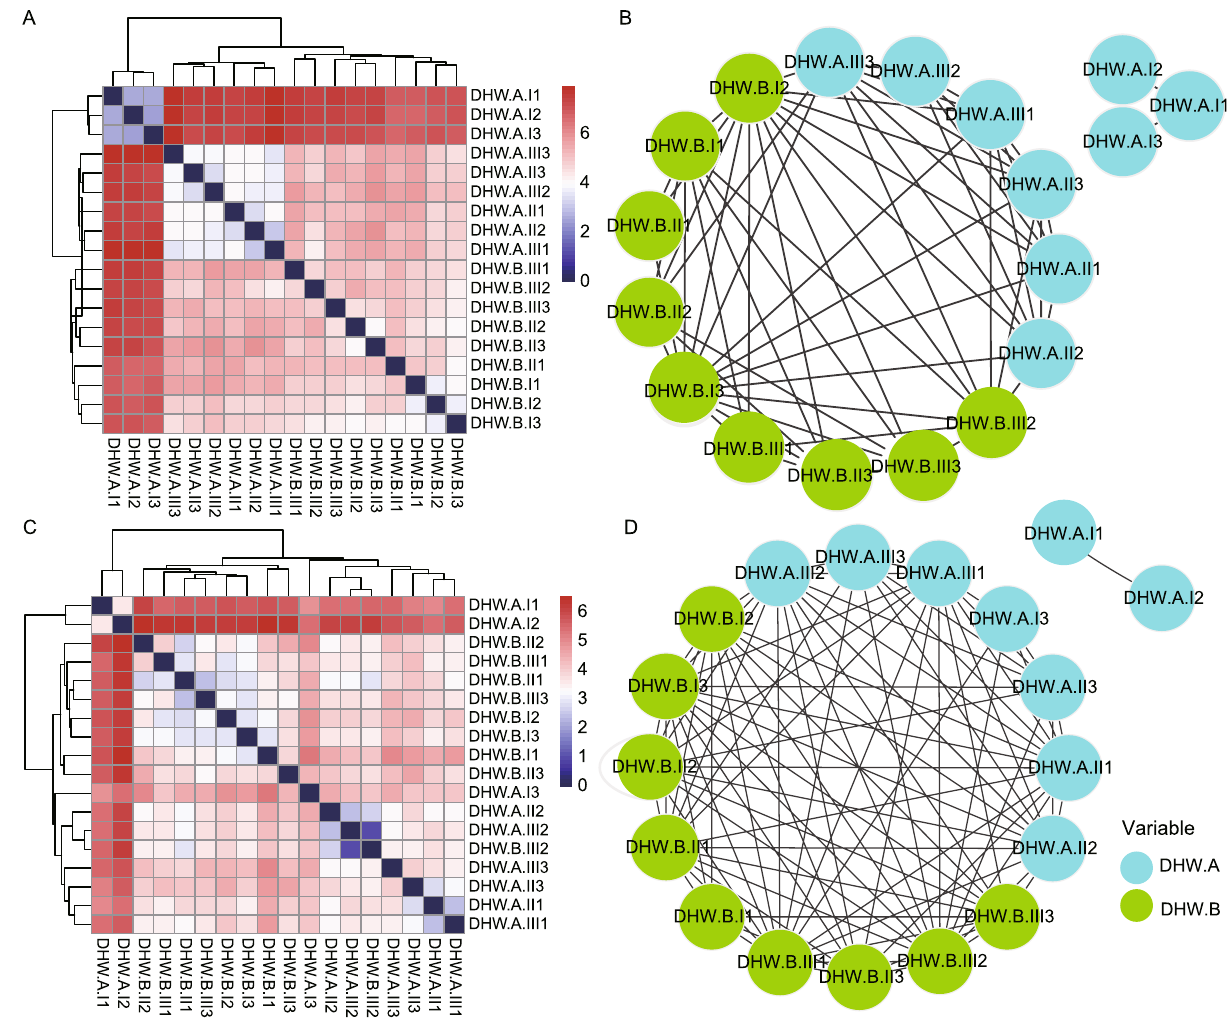
Figure 5. Comparison of the similarity of all DHW samples from intra-/inter-manufacturers based on prescribed herbal materials using Euclidean distances. Heatmap clusters displayed the distance of all samples based on the existence of prescribed herbal species using hierarchical clustering, and network clusters illustrated these differences based on ITS2 ( A , B ) and trnL ( C , D ) sequencing results, respectively. For heatmap ( A , C ), which was drawn in R (version 3.5.2) package “pheatmap” (https:// cran. rstud io. com/ web/ packa ges/ pheat map/ index. html), the gradient color bars mean the distance between any two samples, while the red and the blue color depicts the two extreme distances between samples. For network ( B , D ) that was visualized in Cytoscape (version 3.7.1; https:// cytos cape. org/), each edge represents the distance of any two samples with a distance less than or equal to 5.0 for ITS2 and 4.2 for trnL